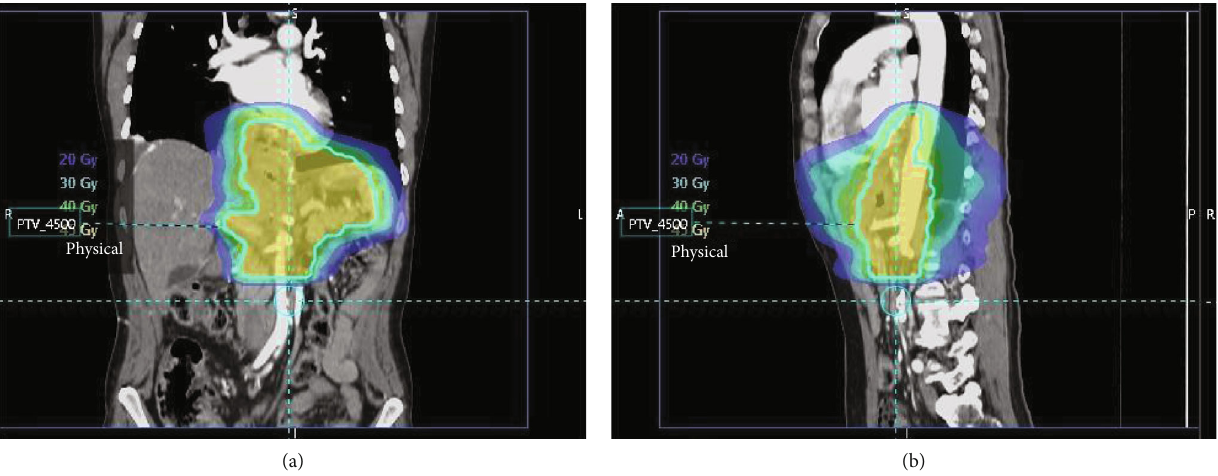
Figure 5: Coronal (a) and sagittal (b) overlays with isodense lines of planned external beam radiotherapy (XRT) with coverage of the surgical